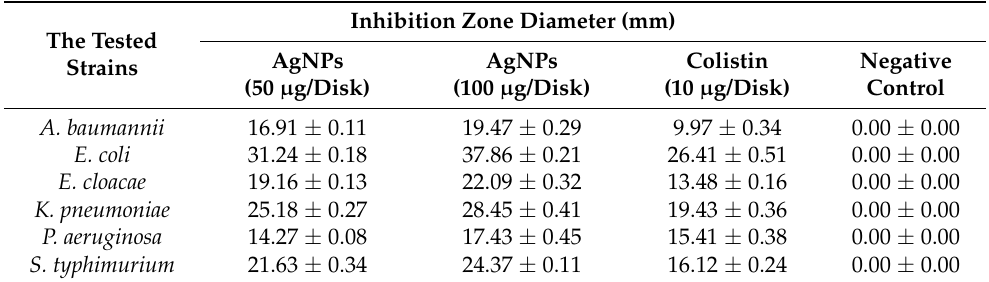
Table 2. Antimicrobial effectiveness of the biogenic AgNPs against the tested bacterial strains. The